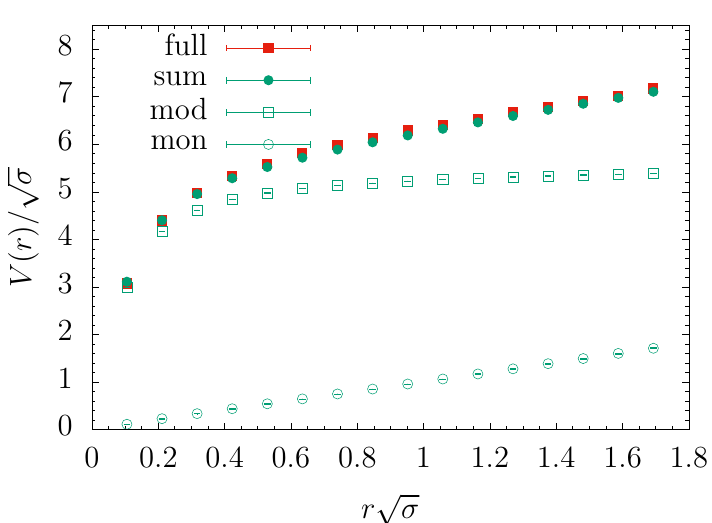
Figure 4. The nonabelian static potential V ( r ) (filled squares) is compared with the sum of the monopole Figure 2. The relative deviation ∆ ( r ) vs. distance r for three values of the lattice spacing. and modified potentials V sum ( r ) (filled circles) for QC 2 D at zero chemical potential. The potentials V mon ( r ) (empty circles) and V mod ( r ) (empty squares) are also shown.